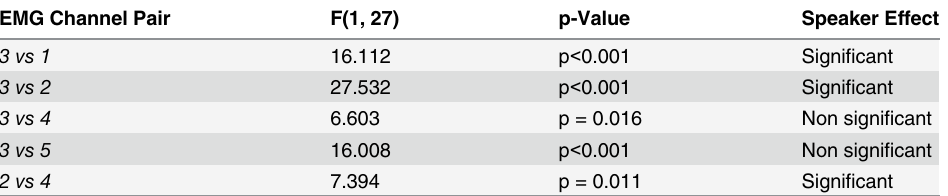
Table 5. Results of the repeated-measures ANOVA analysis for the EMG channel pairs that attained significance level. EMG Channel Pair F(1, 27) p-Value Speaker Effect